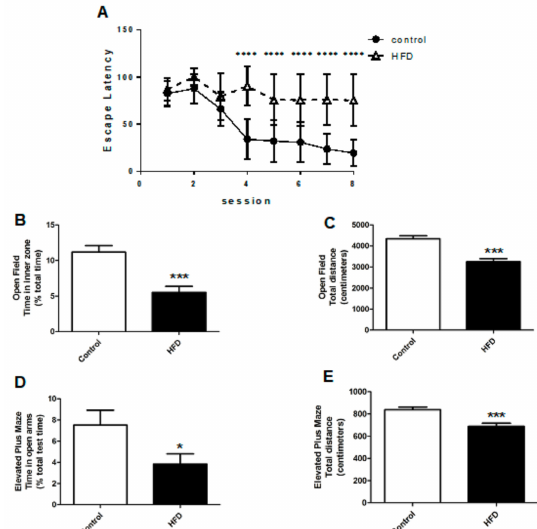
Figure 2. Behavioral tests for cognition, anxiety, and locomotor function in HFD and control mice. ( A ) In the Morris water maze test, HFD mice had significantly delayed escape latencies compared to the controls, indicating impaired cognition. ( B ) In the open-field test (OFT), the HFD mice spent less time in the inner zone, indicating increased anxiety. ( C ) The HFD mice traveled shorter distances compared to those by the controls in the OFT. ( D ) In the elevated plus maze (EPM), the HFD mice spent less time in the open arm, indicating increased anxiety. ( E ) The total distance traveled by HFD mice in the EPM was also less than that traveled by the controls. The asterisks represent the level of statistical significance calculated using a two-tailed Student’s t -test (* p < 0.05, *** p < 0.001, **** p < 0.0001); data are represented as mean ± SEM. ( n = 30 in each group). OFT: open field test; EPM: elevated plus maze; SEM: standard error of